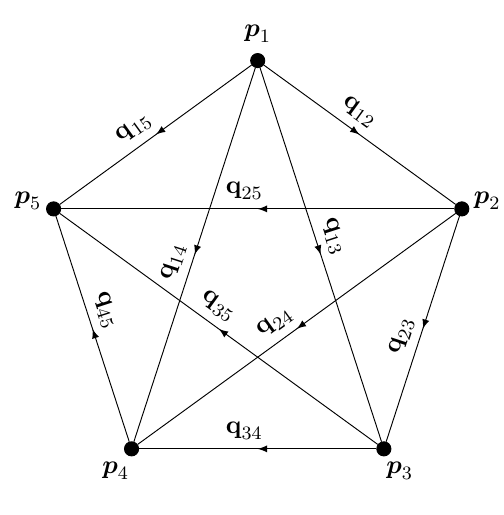
Figure 1 . Structure of the simplex integral, illustrated for the 5 -point